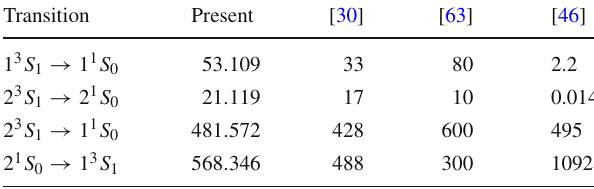
Table 25 M 1 transition width of B c meson (in